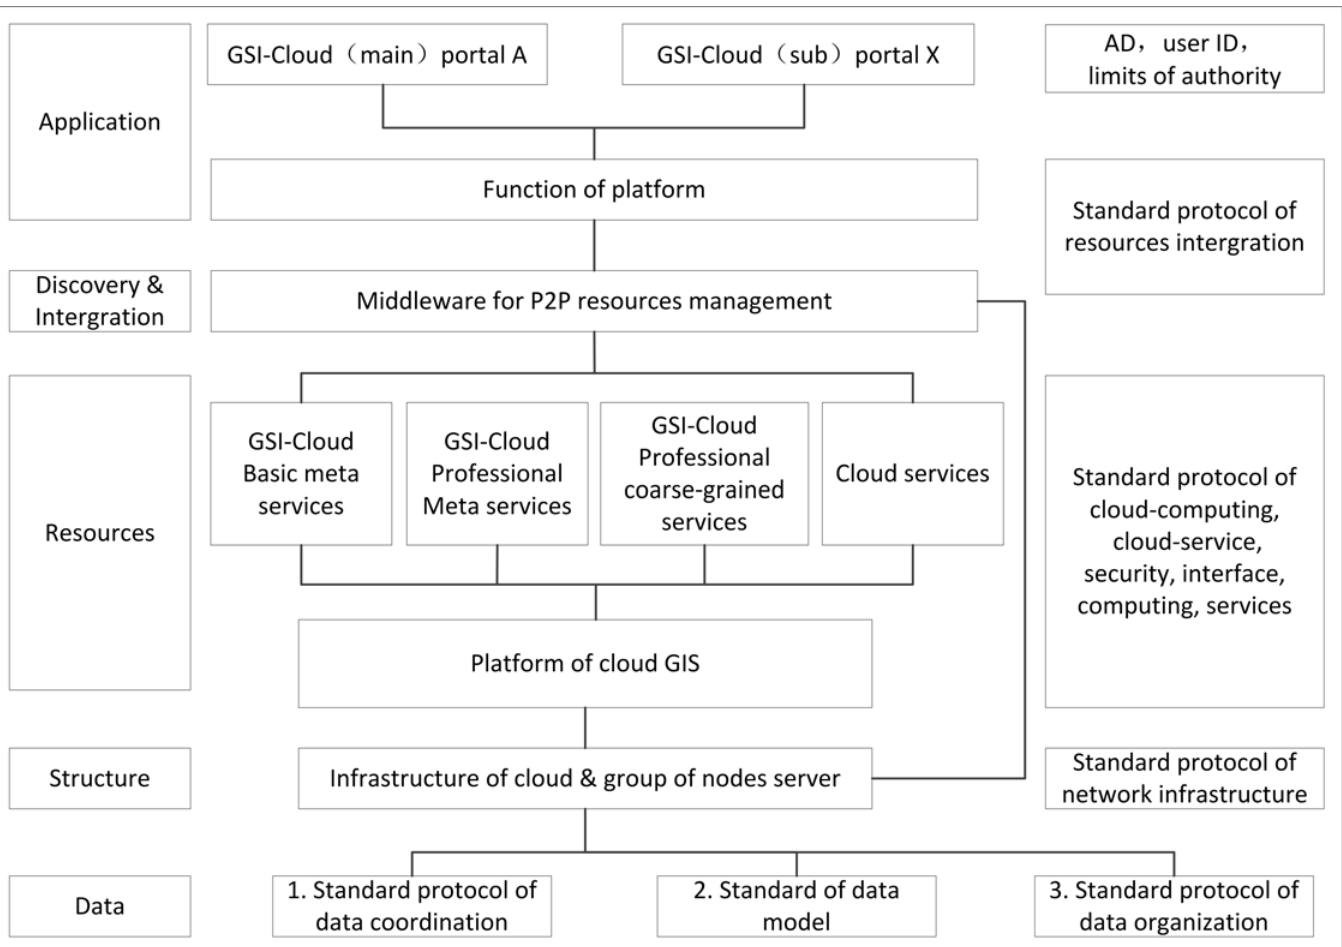
Fig 1. Hierarchical architecture of the geological survey information cloud-computing